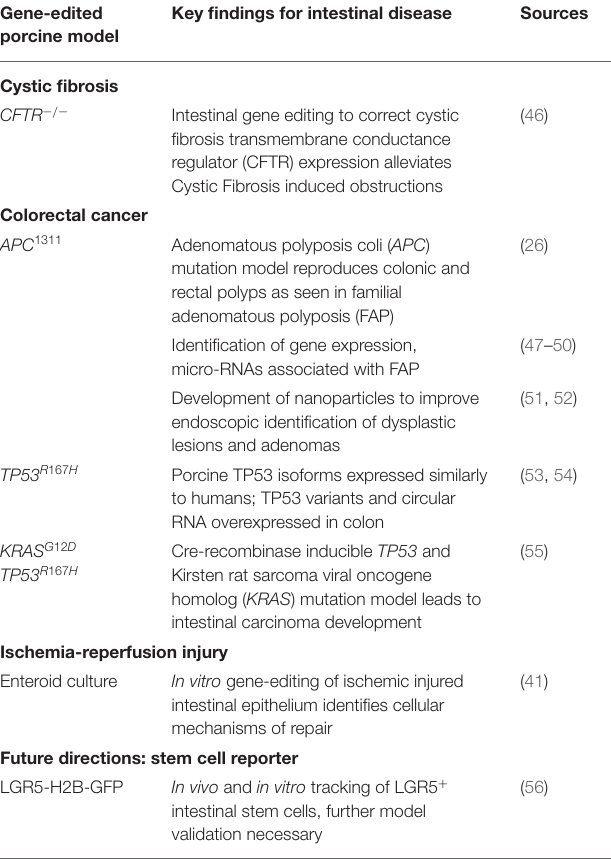
TABLE 2 | Summary of findings from gene-edited porcine models of non-infectious intestinal disease. Gene-edited Key findings for intestinal disease porcine model